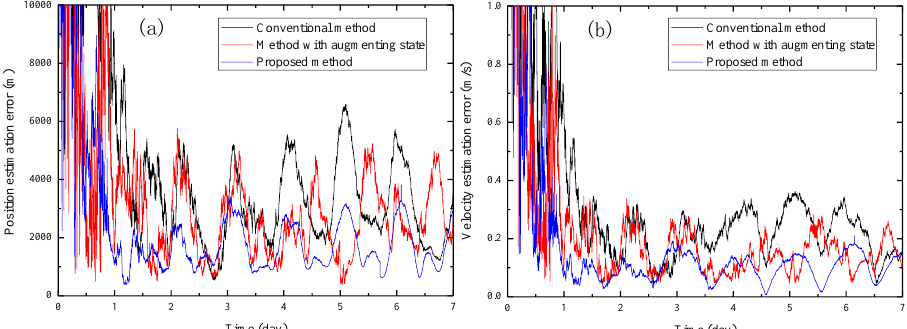
Figure 5. Performance comparison of the proposed method, the method with augmenting state and the conventional method. ( a ) Position estimation error; ( b ) Velocity estimation error.